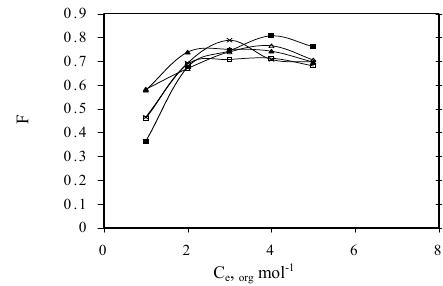
Figure 1. Variation of D with concentration of Amberlite LA-2 in different individual diluting diluents at 25 0 C. ( ∆ , 1-octanol; ■ ,